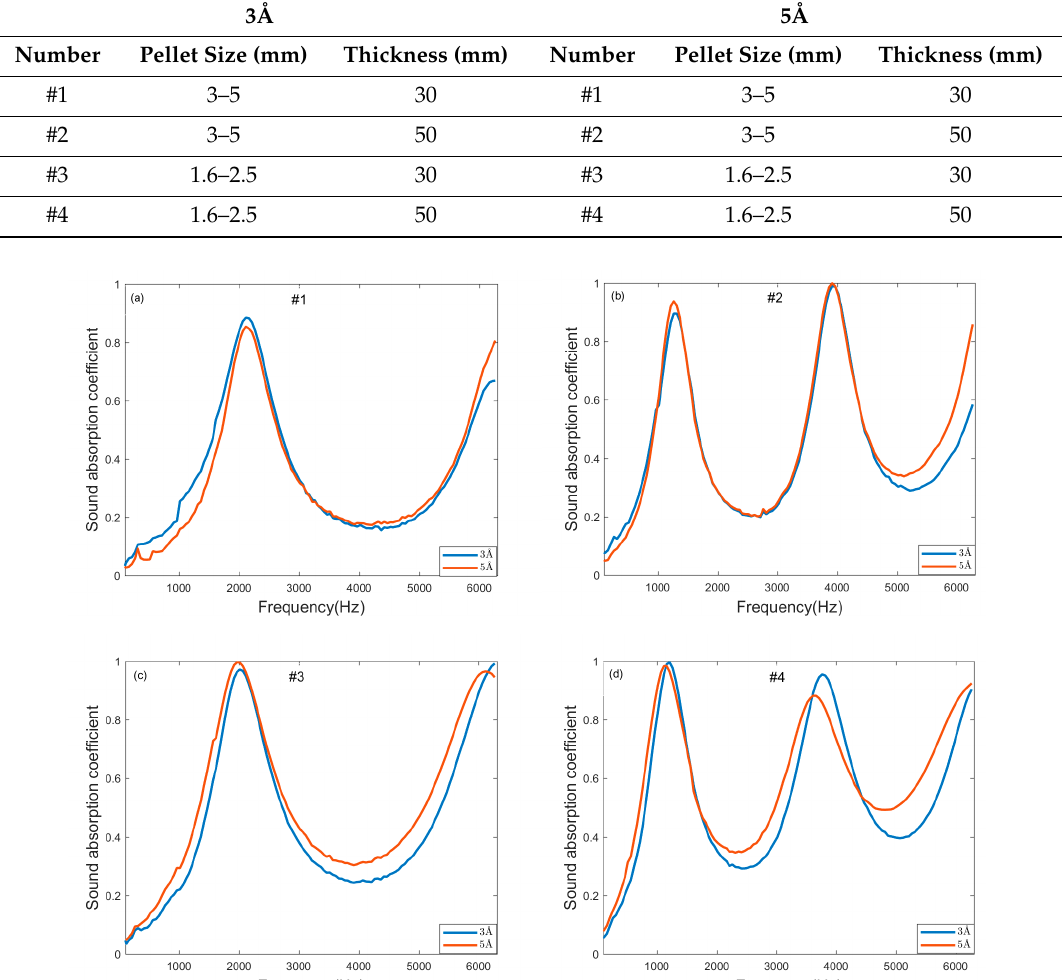
Figure 2. Sound absorption measurement of molecular sieve pellets of different pore size. Sound absorption coefficient of 3Å and 5Å with ( a ) thickness of 30 mm and pellet size of 3-5 mm; ( b ) thickness of 50 mm and pellet size of 3-5 mm; ( c ) thickness of 30 mm and pellet size of 1.6-2.5 mm; ( d ) thickness of 50 mm and pellet size of 1.6-2.5 mm.